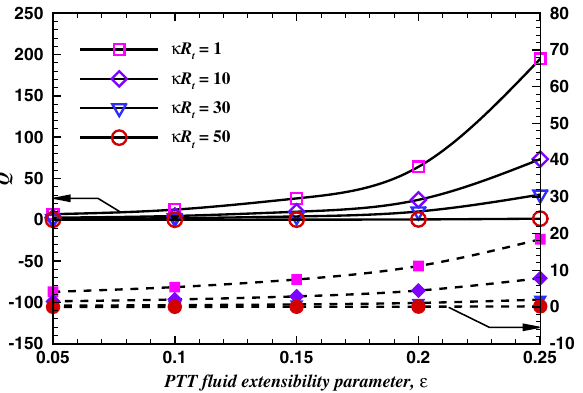
Figure 8. Dimensionless volumetric flow rate variation with ε for various values of κ R t for De = 1 (dashed line) and De = 100 (solid line) at V = 40 , and σ = − 50